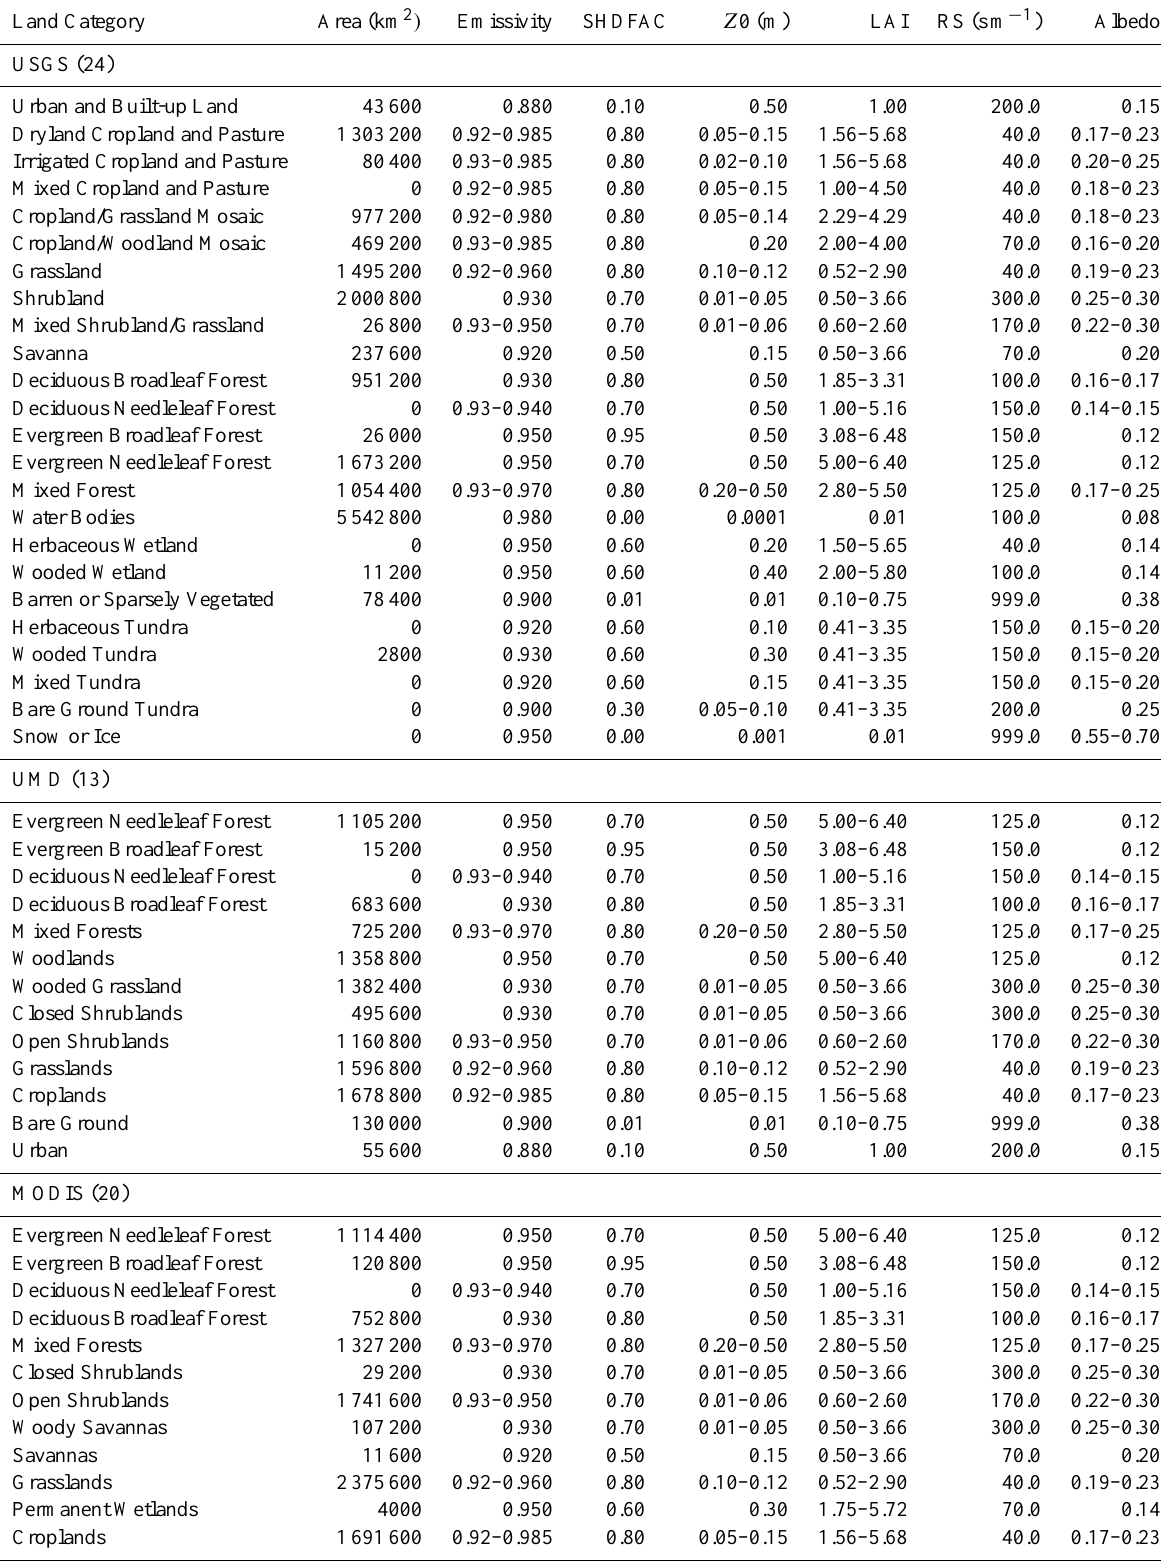
Table 2. Land cover classification and its associated key parameter values. Land